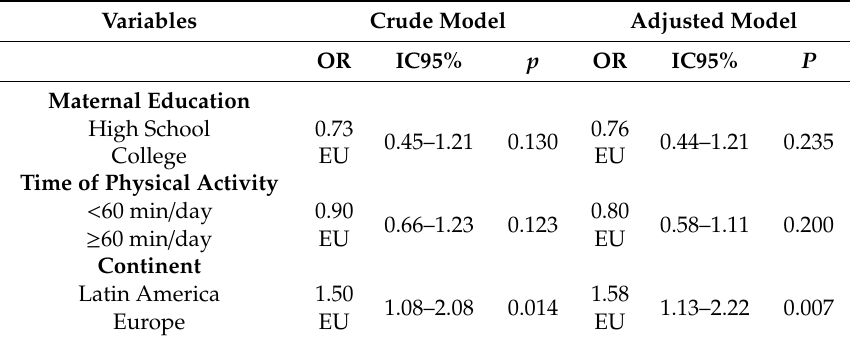
Table 4. Multiple logistic regression model of the variables associated with ultra-processed food